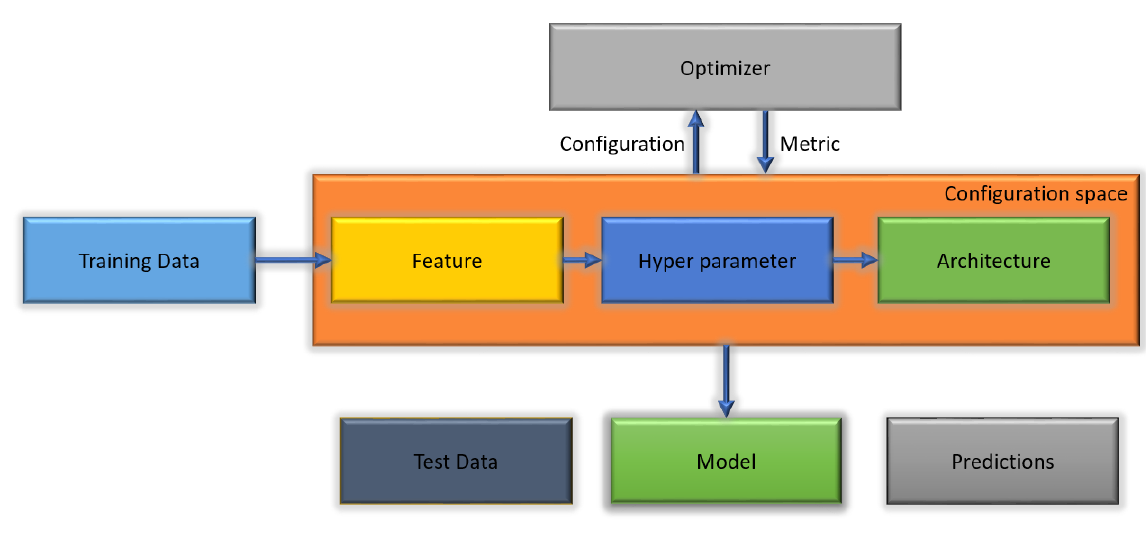
Figure 1. Auto-machine learning